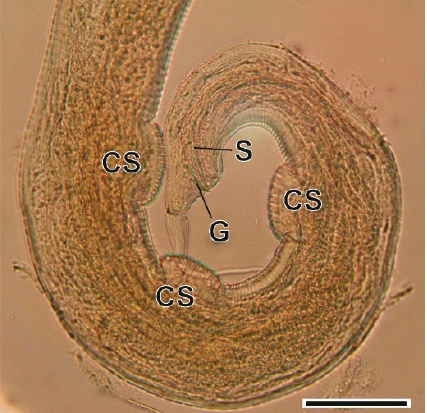
Figure 11. Caudal extremity of a Syphacia nigeriana male. CS, ventral cuticular swellings; G, guber- naculum; S, spicule. Scale bar = 100 µm.